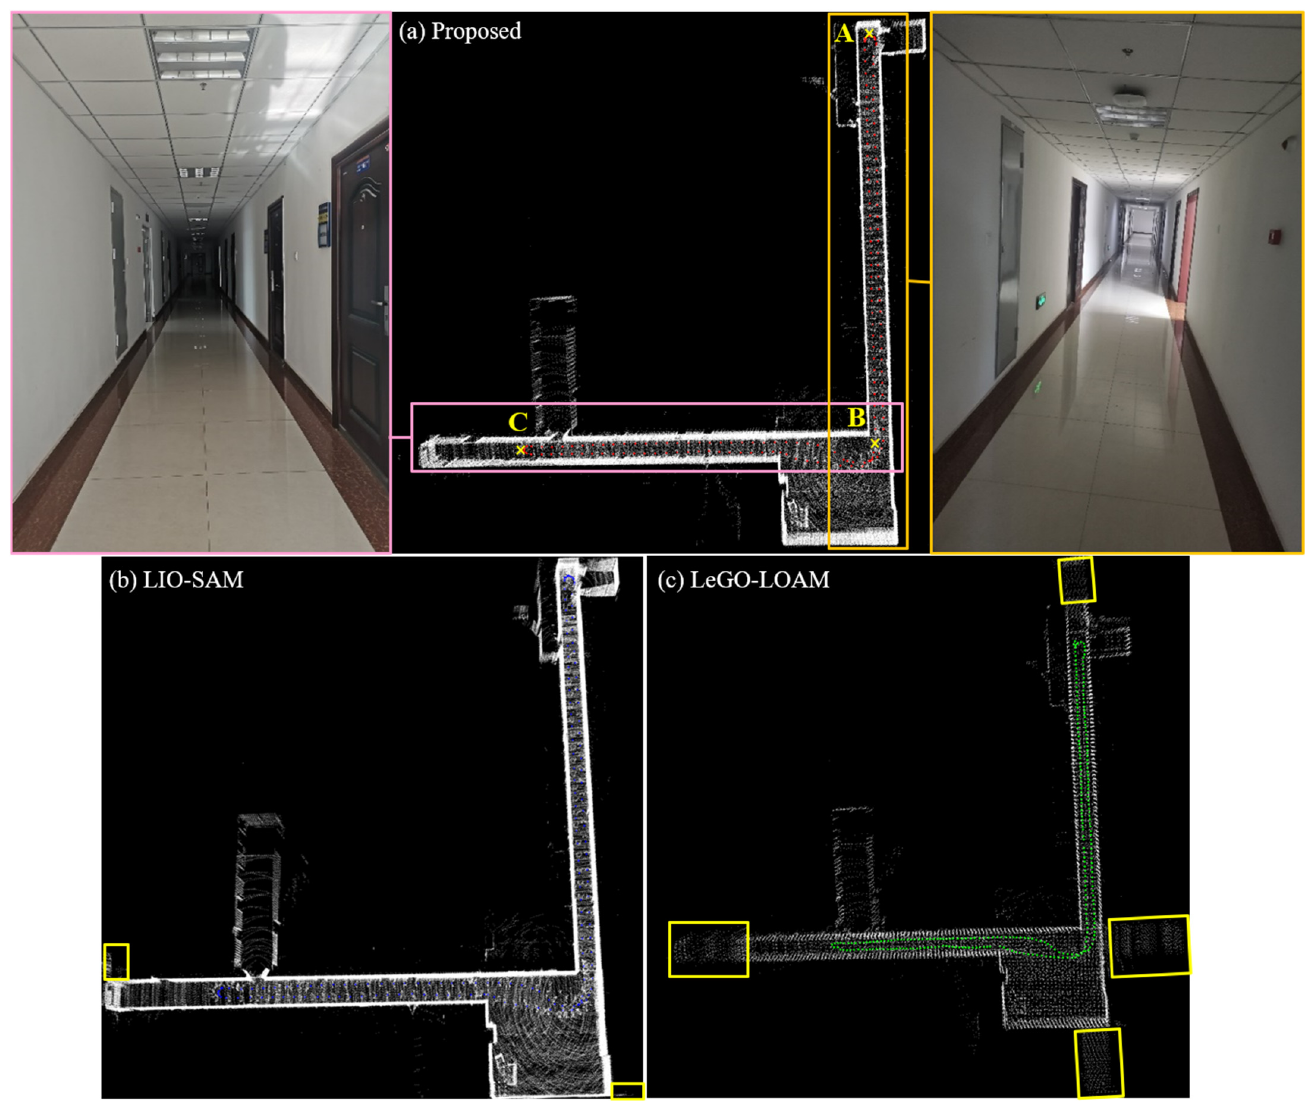
Figure 6. Data collection environment, trajectory and mapping results in the indoor corridor. ( a – c ) Trajectories and mappings of the proposed method, the LIO-SAM method and the LeGO-LOAM method, respectively.